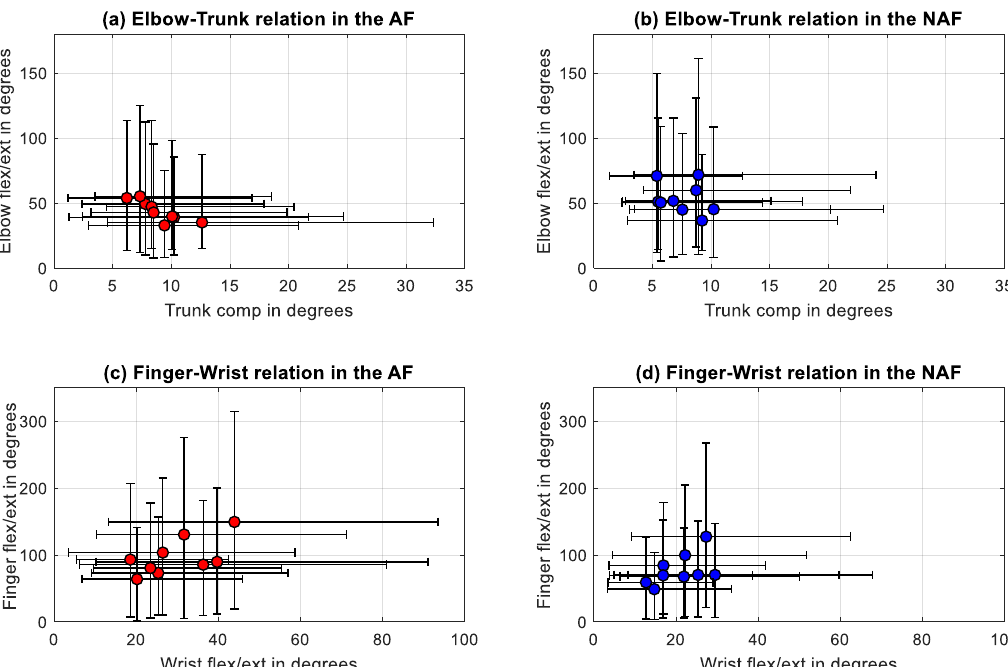
Figure 5. Correlations between ( a ) trunk compensation and elbow flexion/extension in the affected side, ( b ) trunk compensation and elbow flexion/extension in the non-affected side, ( c ) wrist and finger flexion/extension of the affected side, and ( d ) wrist and finger flexion/extension of the non-affected side.